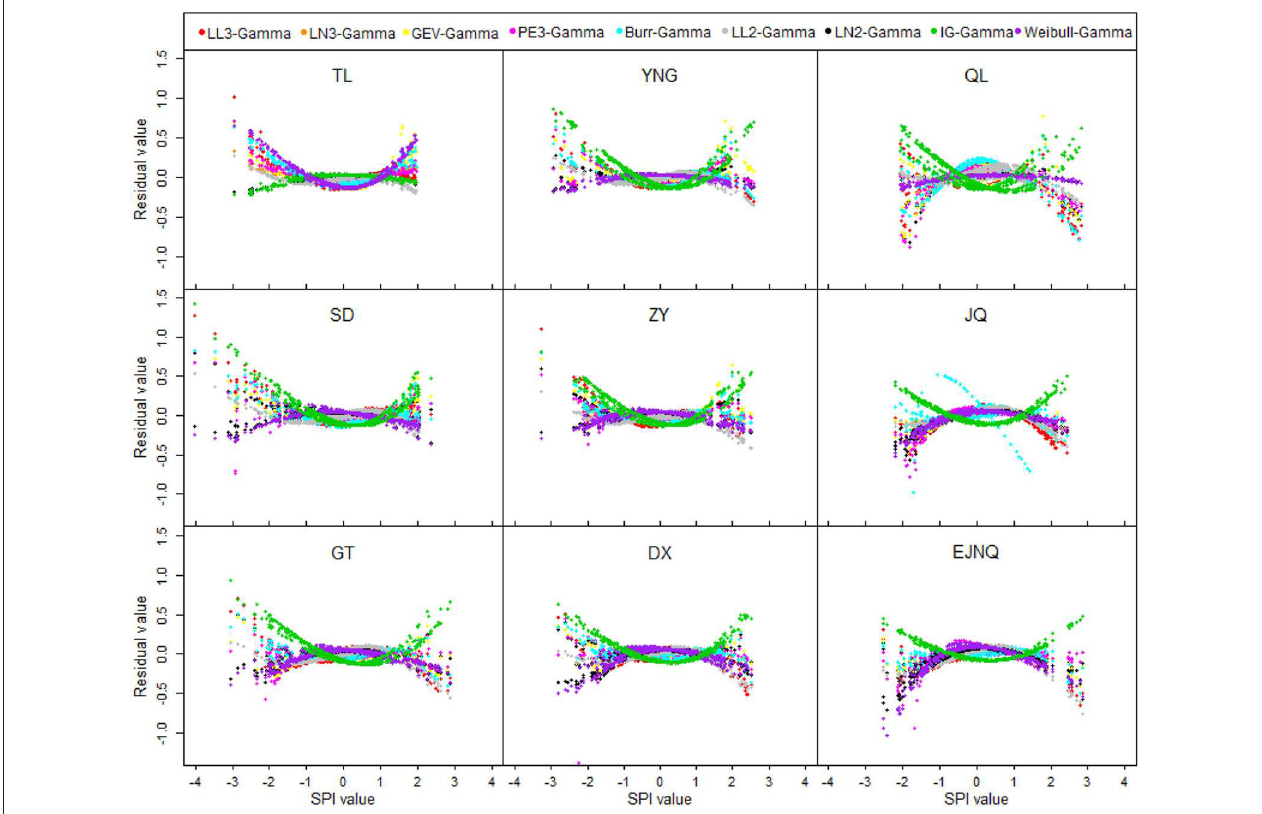
FIGURE 4 | The differences of SPI modeled by gamma and alternative distributions (the abbreviations are the same as in Figure 3 ).